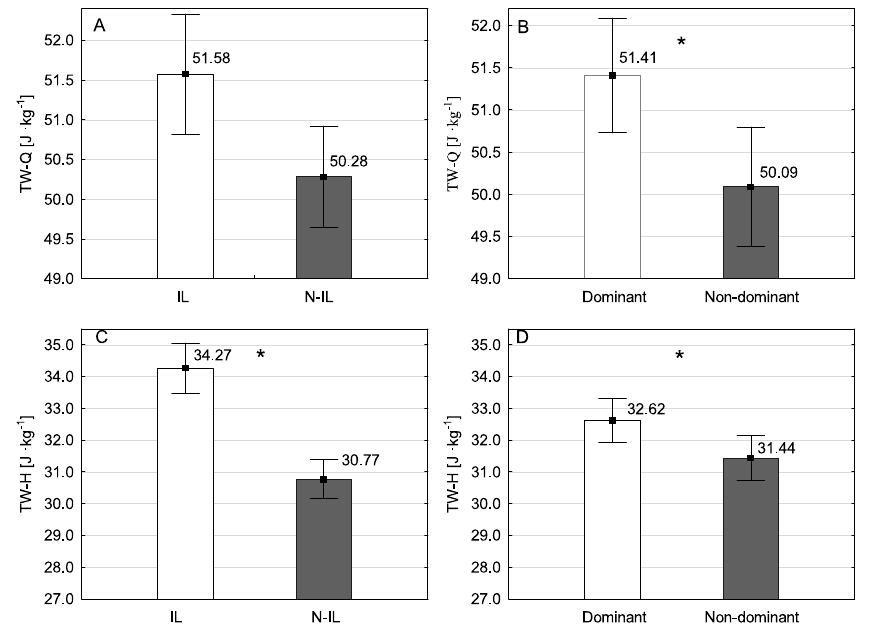
Figure 2. Mean values and standard error for TW of quadriceps and hamstrings ( A , C ) across soccer player groups (international, non ‐ international); ( B , D ) legs (dominant, non ‐ dominant).